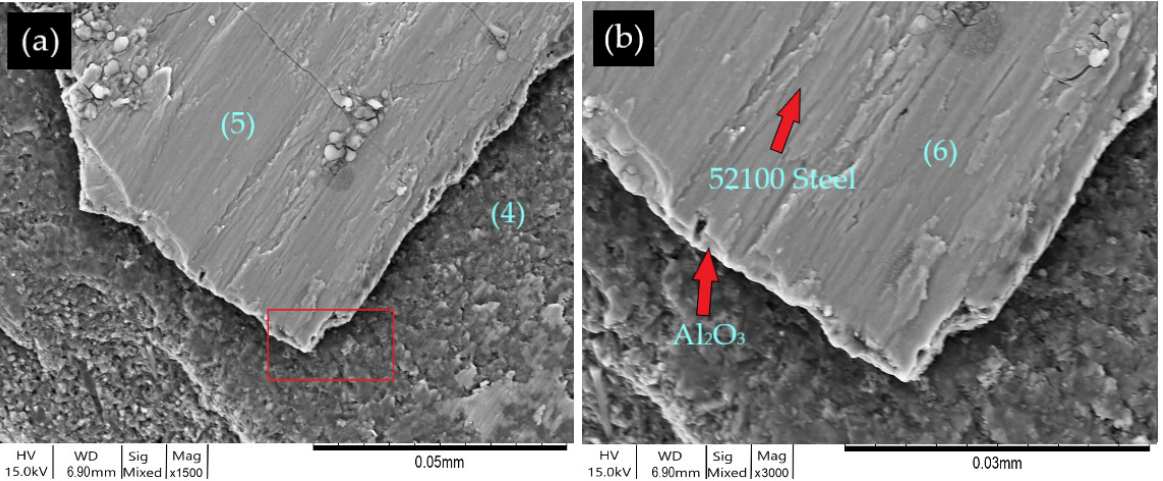
Figure 11. SEM images of Coating A after pin-on-disc Test 2a: ( a ) ×1500 magnification, ( b ) ×3000 magnification.